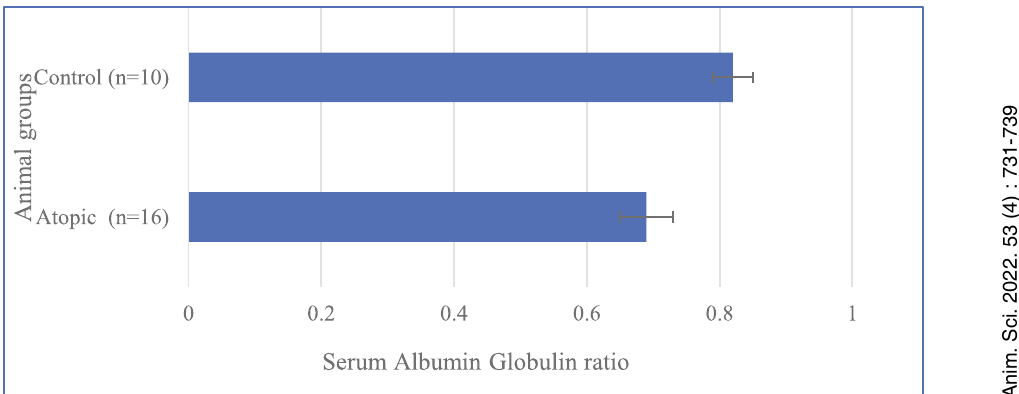
Fig. 7. Serum albumin in atopic and healthy